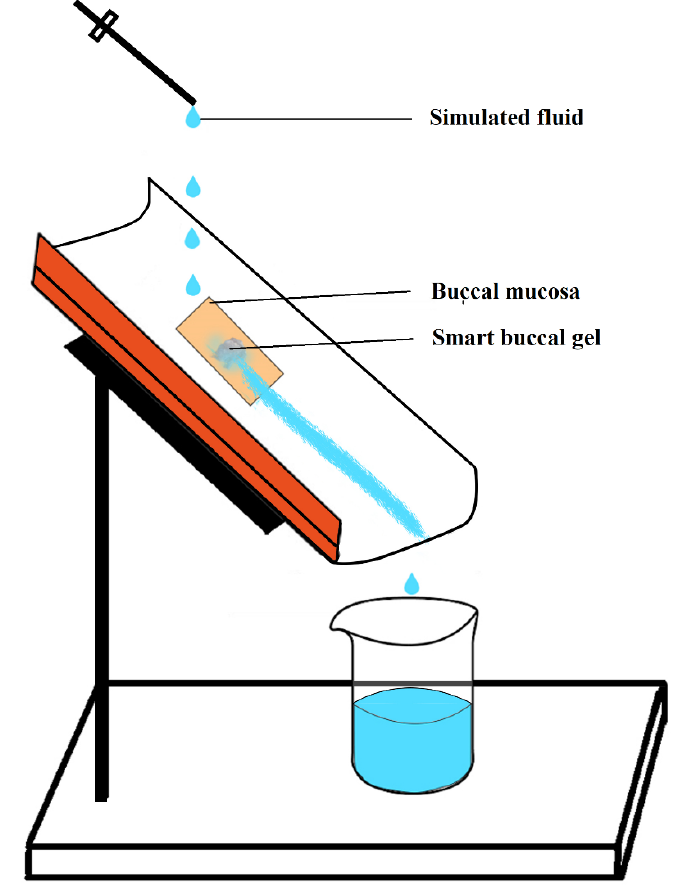
Figure 3. Simulation for estimation of ex vivo mucoadhesive flow time as reported [24].